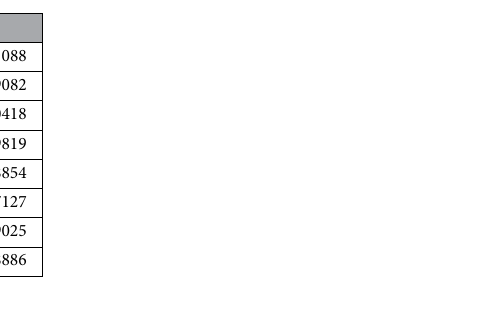
Table 2. The classification results of